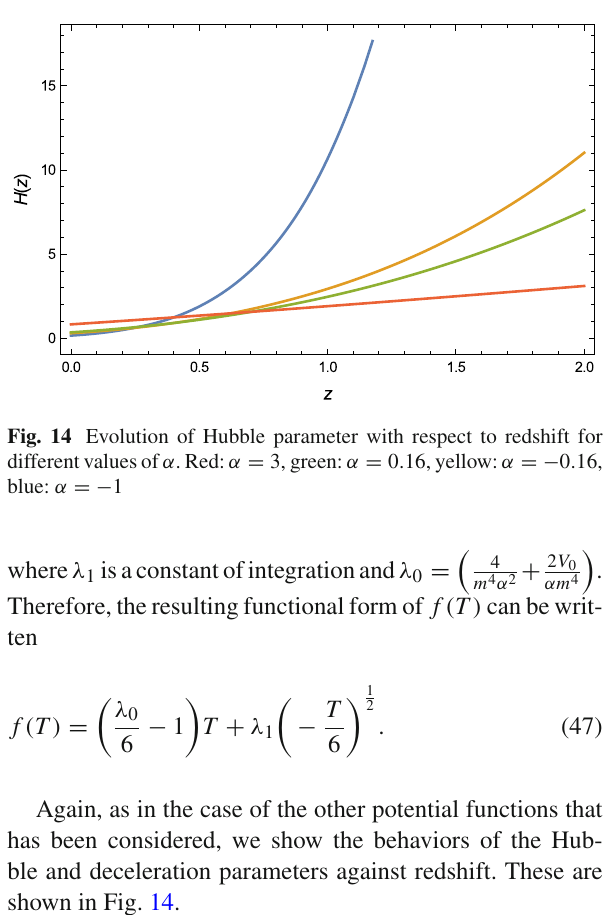
Fig. 12 Evolution of the scale factor with cosmic time. The various colors take on the following values of V 0 as follows. Red: V 0 = 10, blue: V 0 = 1,yellow: V 0 = − 1,andgreen: V 0 = − 10.The α parameter is fixed by α = 1 6